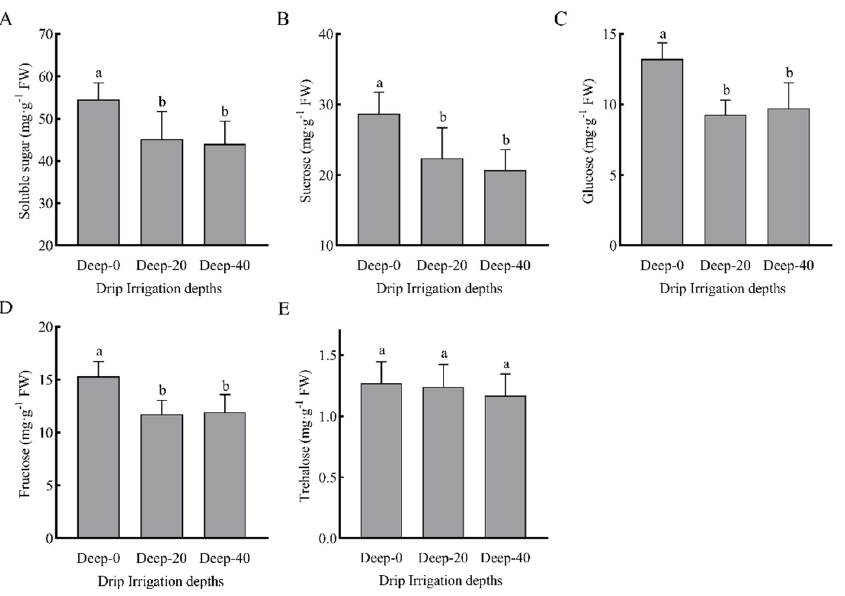
Figure 11. Non-structural carbohydrate contents in the crown of alfalfa plants under three drip irrigation depths. ( A ) Soluble sugar, ( B ) sucrose, ( C ) glucose, ( D ) fructose, and ( E ) trehalose. Different lower-case letters above bars indicate a significant difference between irrigation depths ( p < 0.05, LSD test).